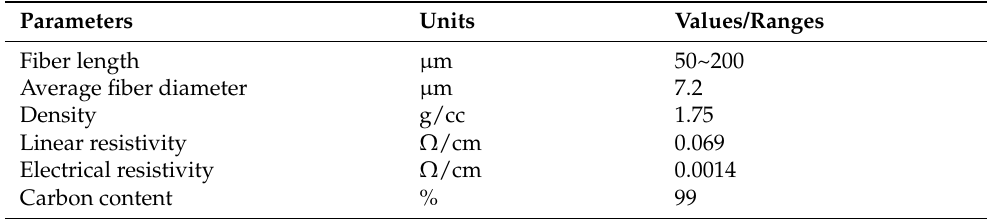
Table 1. Carbon fiber